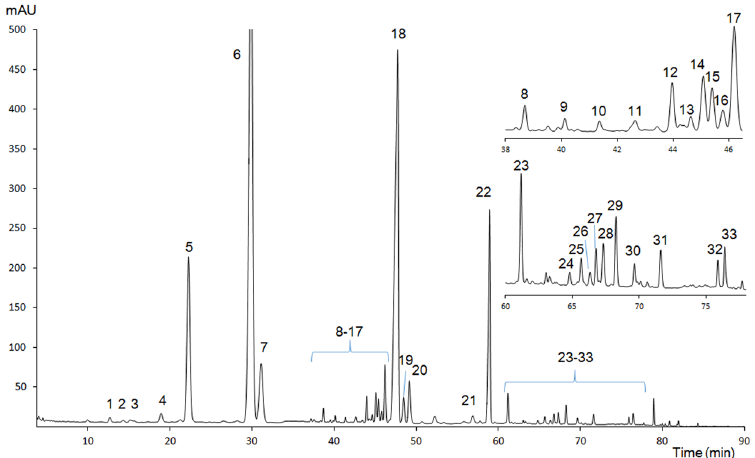
Figure 5. HPLC fingerprint chromatogram of XST. 1. 20-O-Glucoginsenoside Rf, 2. Yixinoside A/Gypenoside XLIV, 3. Notoginsenoside N, 4. Ginsenoside M 6-a , 5. NG-R 1 * , 6. G-Rg 1 * , 7. G-Re * , 8. Vinaginsenoside R 20 , 9. 3 β ,12 β ,20S-trihydroxydammar-(E)-24-ene-6-O- β -D-xylopyranosyl-(1 → 6)- β -D-glucopyranoside, 10. Notoginsenoside A, 11, Notoginsenoside D/Notoginsenoside T, 12. Notoginsenoside Fa, 13. Notoginsenoside U, 14. Chikusetsusaponin VI, 15. Chikusetsusaponin L 5 /Notoginsenoside I, 16. 5,6-Didehydroginsenoside Rb 1 , 17. 20(S)-NG-R 2 * , 18. G-Rb 1 * , 19. G-Rg 2 * , 20. G-Rh 1 * /Ginsenoside Ra 1 , 21. G-F 1 * , 22. G-Rd * , 23. Gy-XVII * , 24. NG-T 5 * , 25. 20D-NG-R 2 * /Ginsenoside Rg 6 , 26. G-F 4 * , 27. G-F 2 * , 28. G-Rk 3 * , 29. G-Rh 4 * , 30. 20(S)-G-Rg 3 * , 31. Falcarindiol, 32. G-Rk 1 * , 33. G-Rg 5 * . ( * Identified with reference